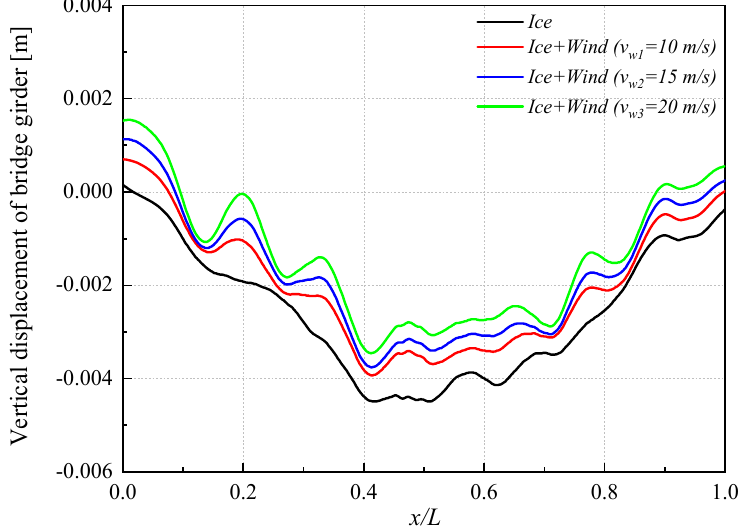
Figure 16. Vertical displacement of bridge girder under combined ice and wind loads.